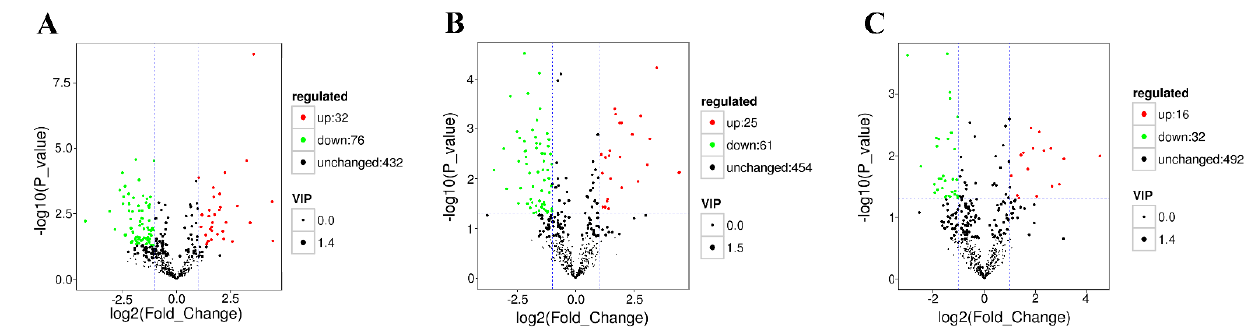
Figure 2. Volcanic map of differential metabolites from three comparisons between control and dead group ( A ), control and moribund group ( B ), and control and group ( C ) of Macrobrachium nipponense . The x - and y -axis are the log2-fold change and the log10 p -value of student’s T test between the two compared groups. Red points represent up-regulated metabolites. Green points represent down-regulated metabolites. Black points represent detected but insignificant differences.